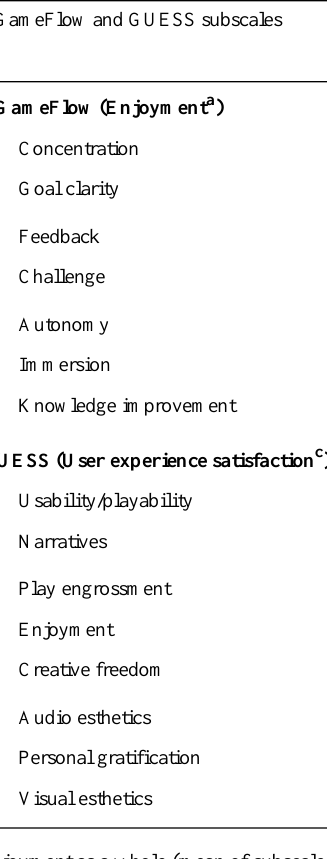
Posttest knowledge scoreEGameFlow and GUESS